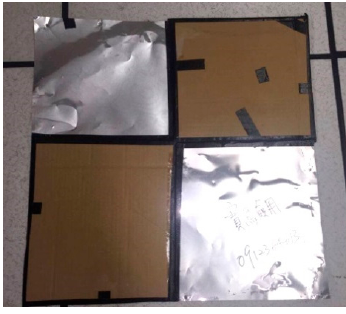
Figure 4. Aluminum target designed for control or check points.